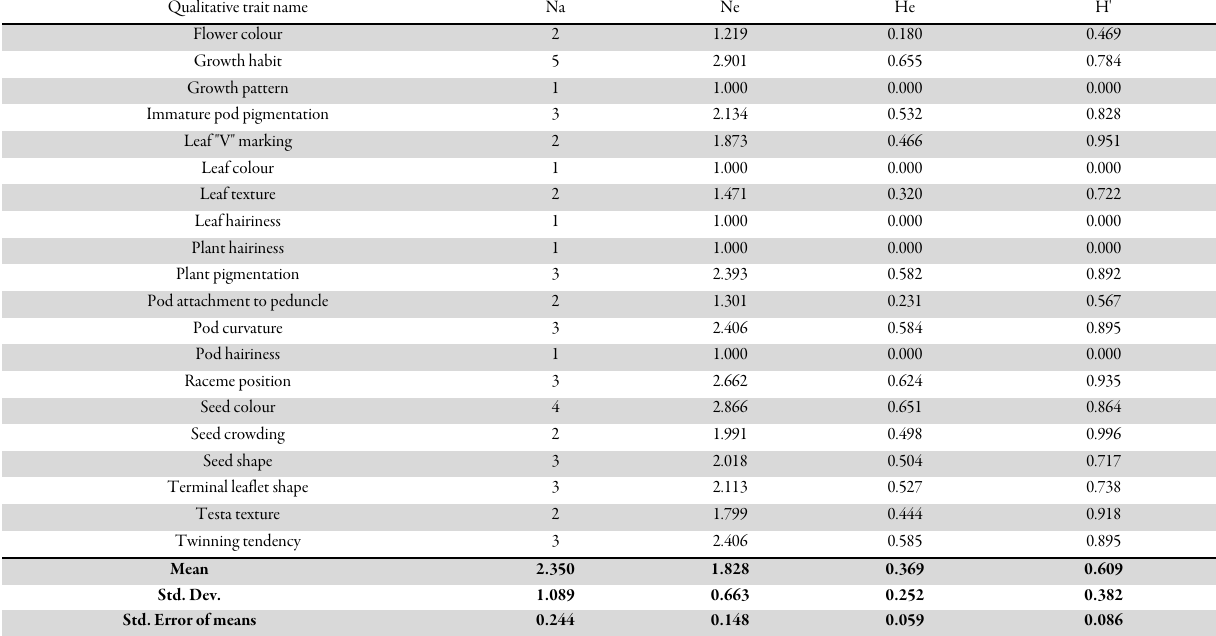
Table 2. Diversity parameters of phenotypic qualitative traits in cultivated Vigna unguiculata Qualitative trait name